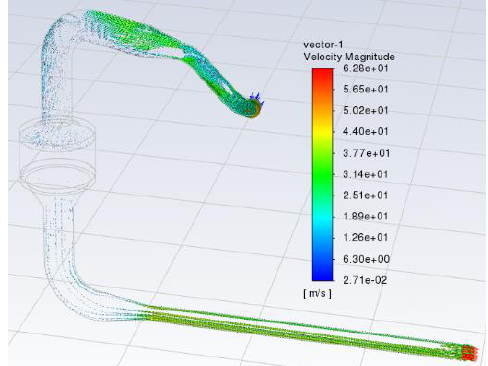
Fig. 15. Velocity profile for 0.016 kg/s mass flow and ambient pressure outlet